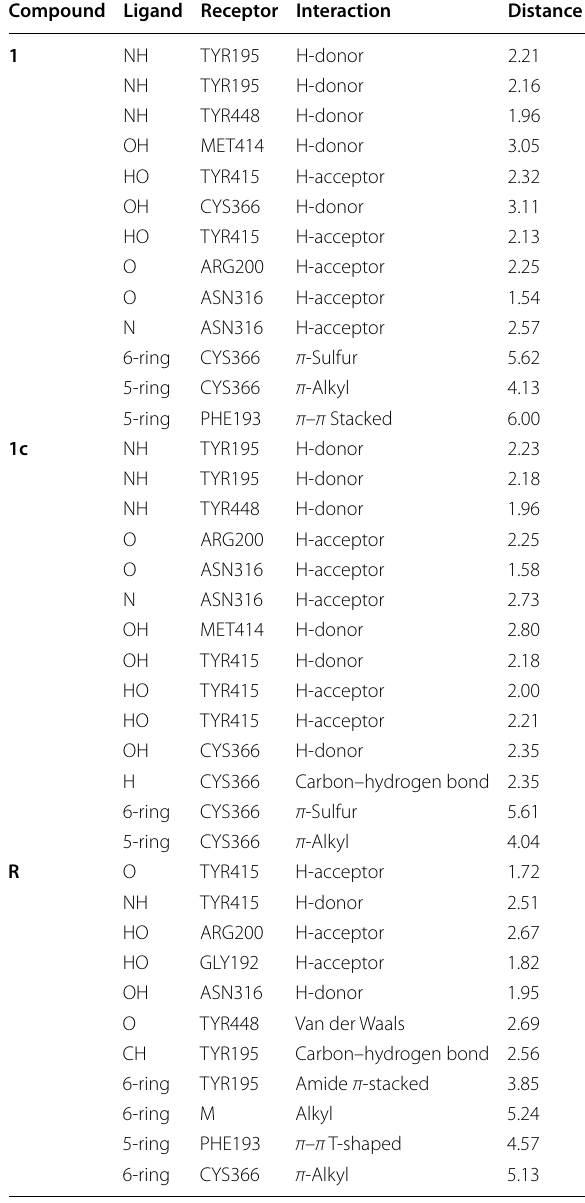
Table 2 The natures of interactions intricate in the template (molecule 1), new molecule (1c), and Sofosbuvir (R) Compound Ligand Receptor Interaction